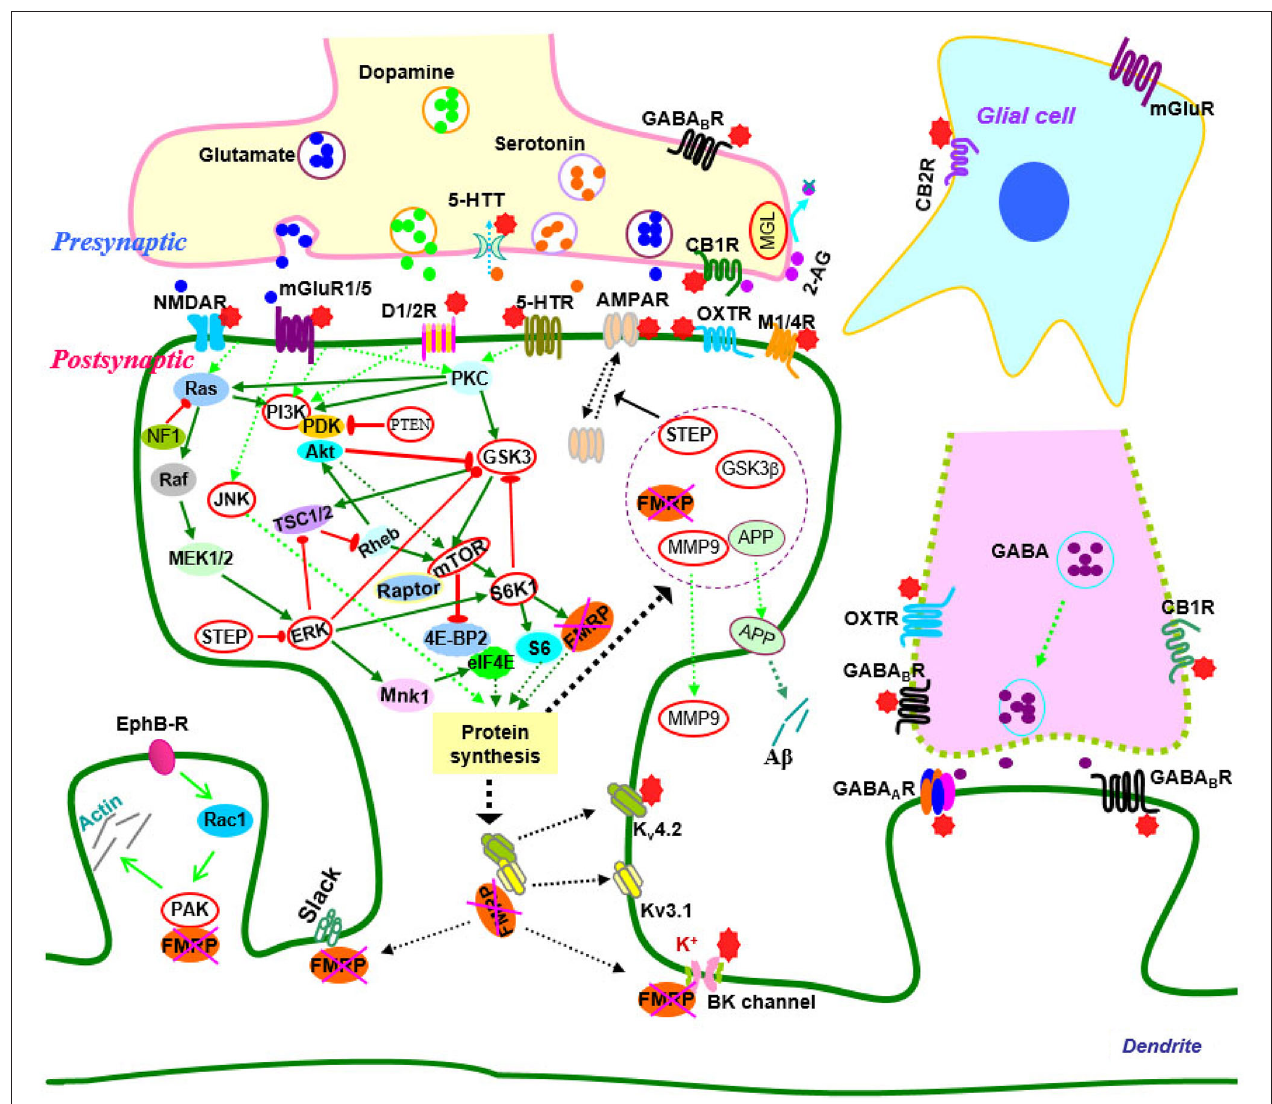
GABA A(B) receptors; GSK3, glycogen synthase kinase-3; JNK, c-Jun N-terminal kinase; M1/4R, muscarinic acetylcholine receptor 1/4; MEK, mitogen-activated protein kinase/ERK kinase; MGL, monoacylglycerol lipase; mGluR, metabotropic glutamate receptor; MMP9, matrix metalloproteinase 9; MSK, mitogen and stress-activated protein kinase; mTOR, mammalian target of rapamycin; NF1, neurofibromatosis 1; NMDAR, N-methyl-d-aspartate receptors; OXTR, oxytocin receptor; PAK, p21-activated kinase; PI3K, phosphatidylinositol 3-kinase; PKC, protein kinase C; PP2A, protein phosphatase 2A; PTEN, Phosphatase and tensin homolog; Raptor, regulatory-associated protein of mTOR; RSK, p90 ribosomal S6 kinase; S6K1, p70 ribosomal kinase 1; STEP, striatal-enriched protein tyrosine phosphatase; TSC1/2, tuberous sclerosis complex